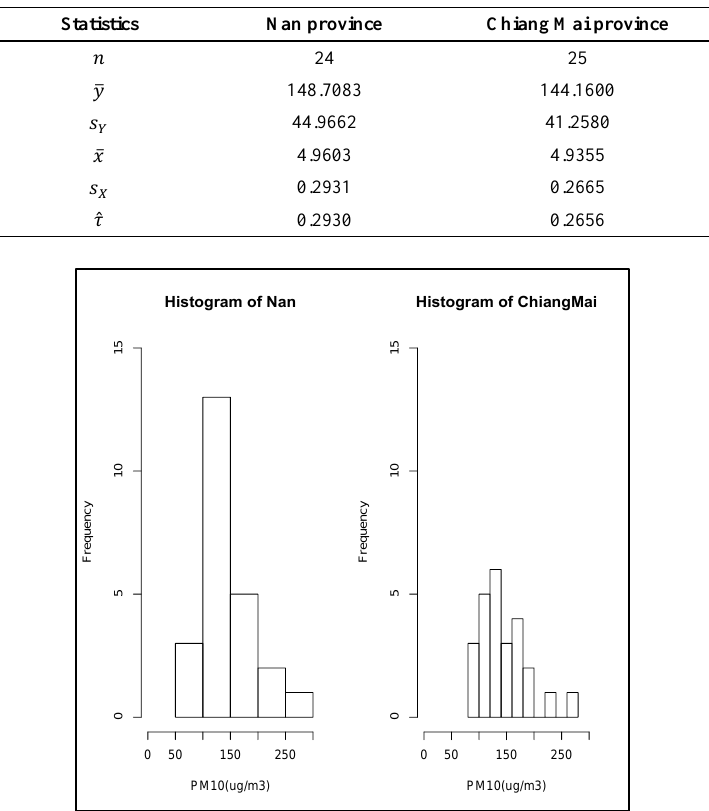
Figure 2. Histogram plots of PM10 data of the Nan and Chiang Mai provinces.